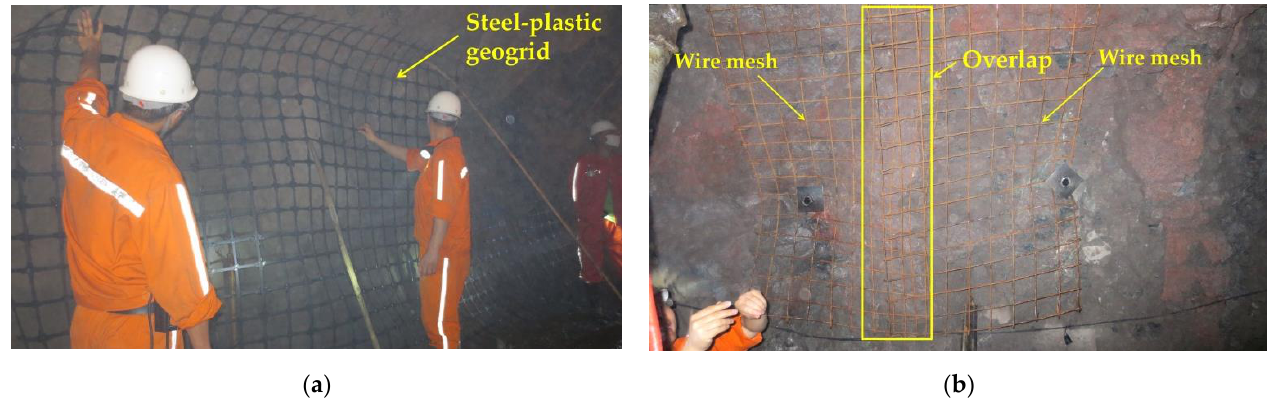
Figure 13. Site hanging construction drawings: ( a ) wire mesh; ( b ) steel-plastic geogrid.